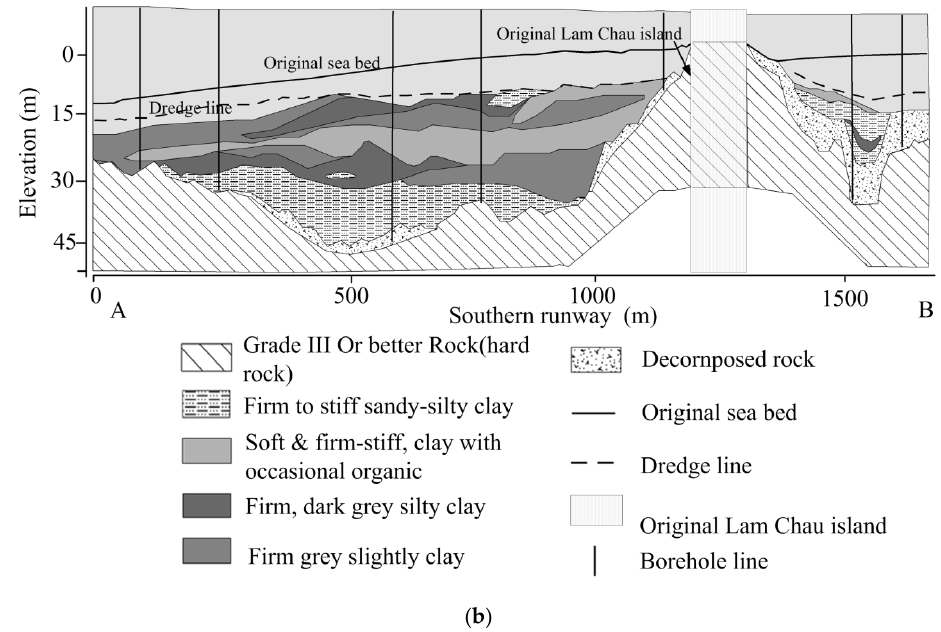
Figure 2. The geological setting and cross sections of HKIA. ( a ) The bedrock geology of HIAK, ( b ) the geological cross-section of the southern runway of the airport, the location of which is labeled as white dotted line A-B in Figure 2 a (after Figure 1 and 3 in [3]).